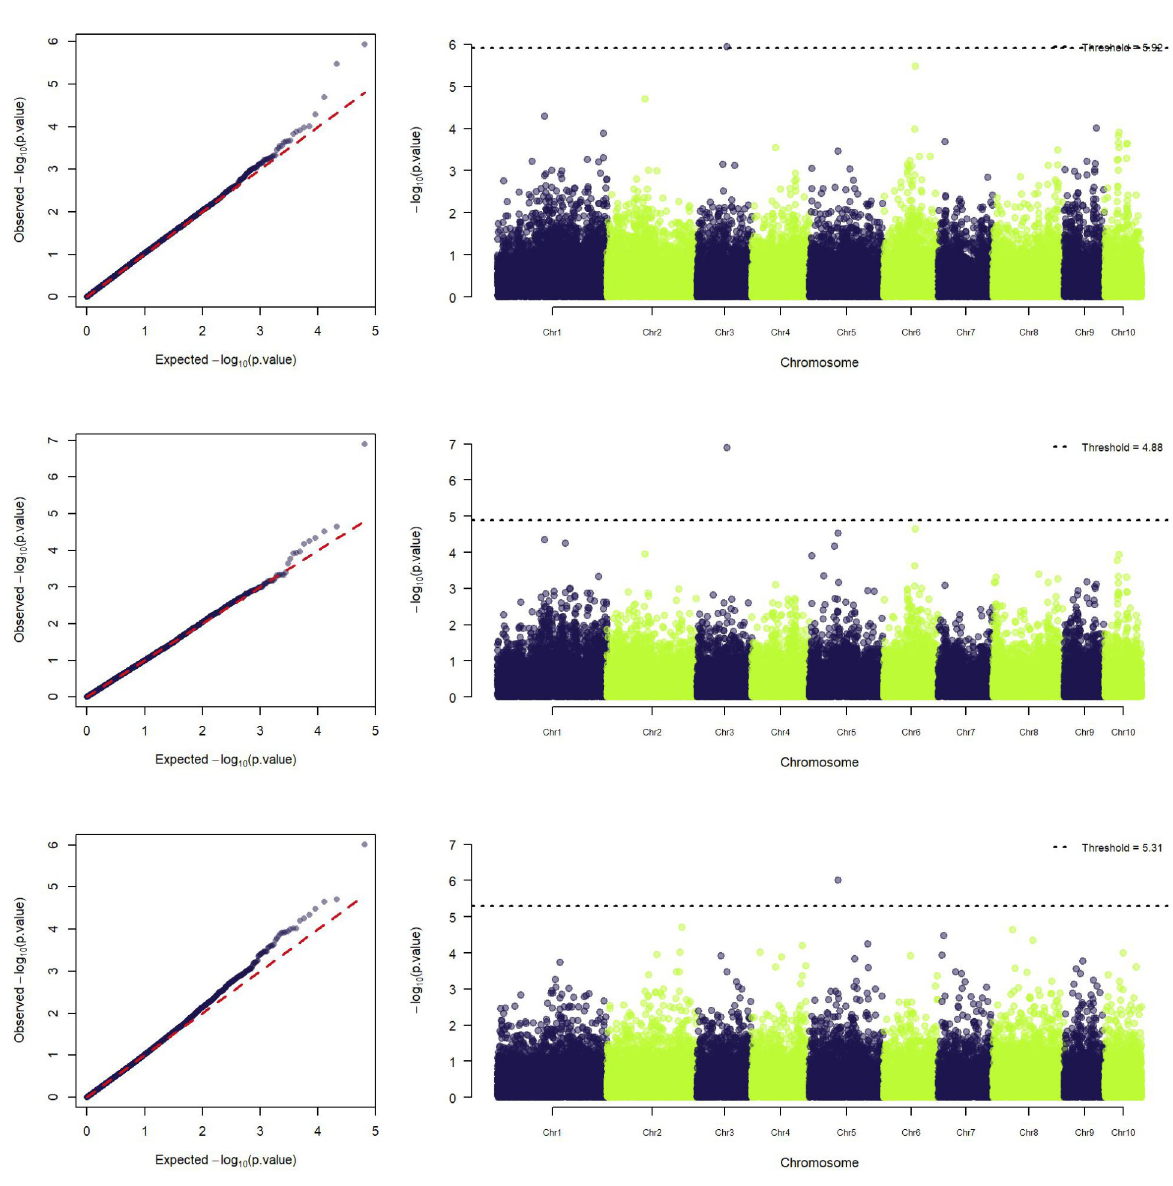
Fig 3. Manhattan and QQ-plots of GWAS for GY LN (Top) and GY IN (middle and bottom). Plots represent additive effect with model S AD + G AD (top and middle); and dominance effect with model S D + G AD (bottom). Analyses were carried out on 904 maize single-crosses using 34,571 markers.